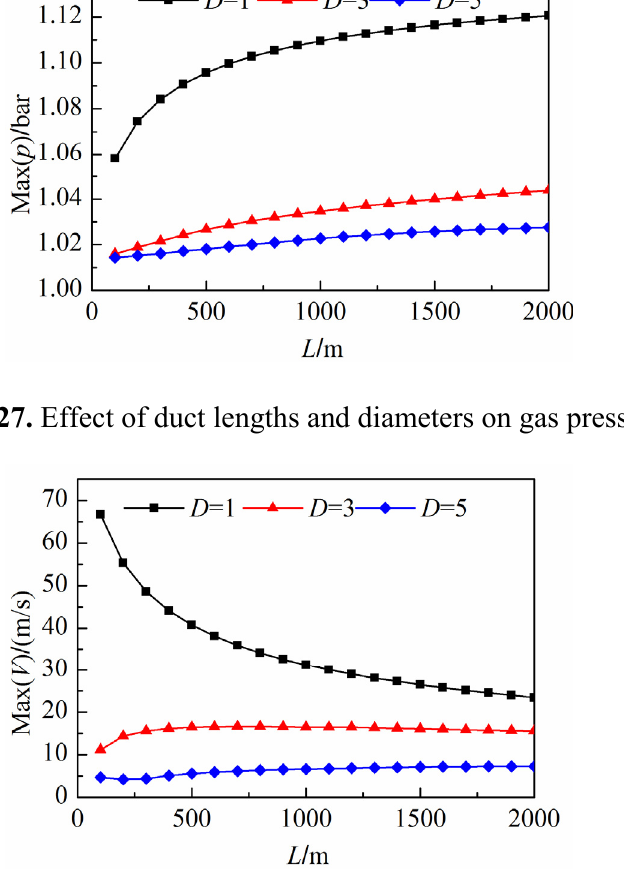
Figure 28. Effect of duct lengths and diameters on wind